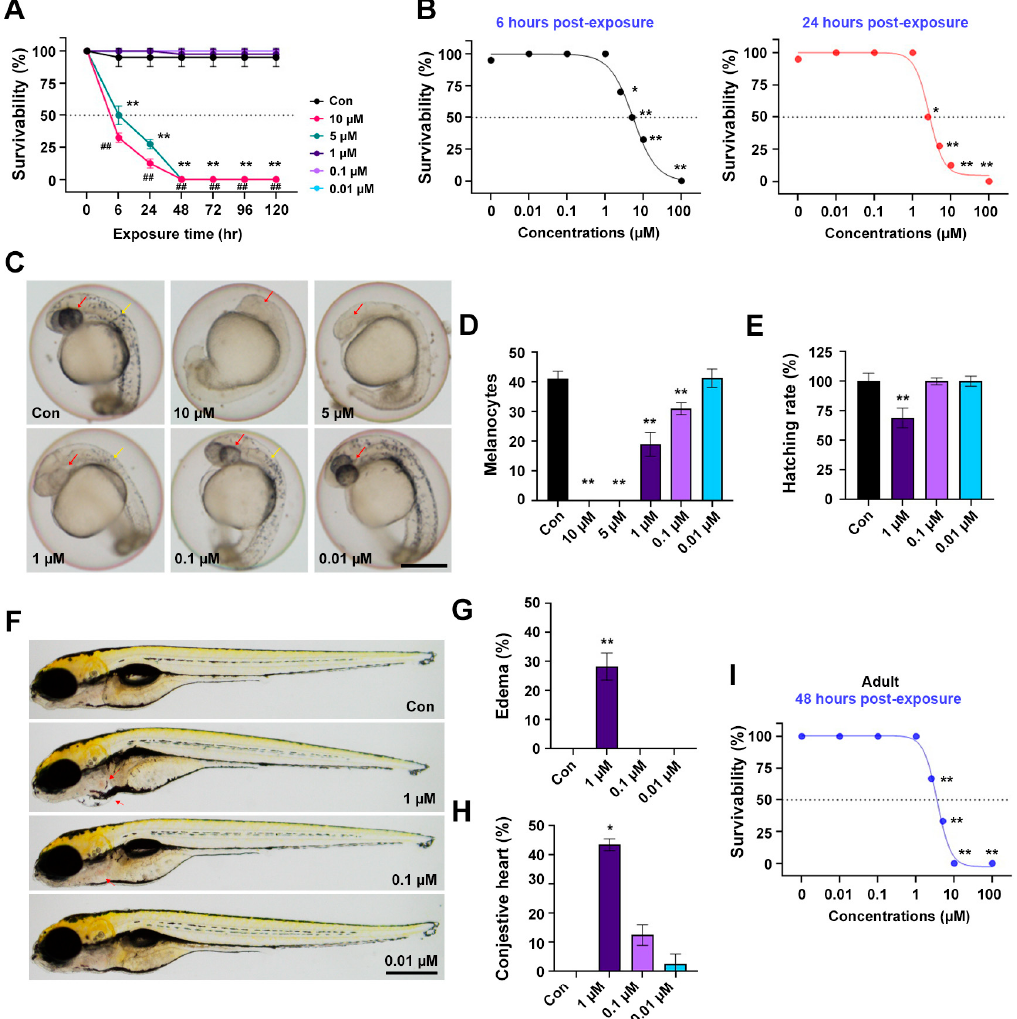
Figure 7. In vivo toxicity assay of 3f in the embryo and adult zebrafish. ( A ) Time-dependent survival rates throughout 0–120 h post exposure (hpe) in zebrafish embryos (n = 25 embryos/group). * p < 0.05, ** p <